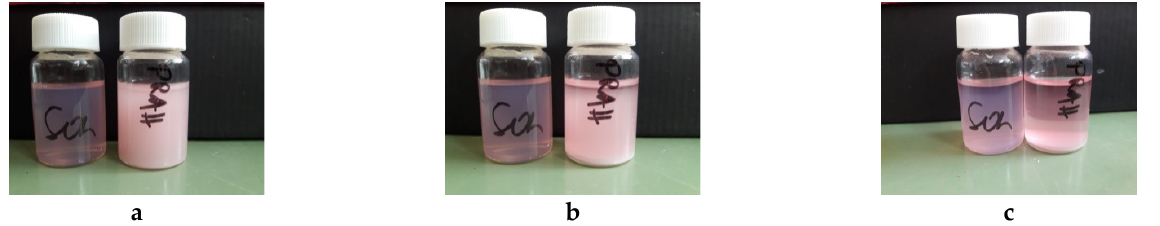
Figure 2. Visual observation of ceria sol (bottles on the left) and ceria powder-containing (bottles on the right) electrolytic baths after magnetic stirring: ( a ) 0 min, ( b ) 3 min, and( c ) 6 min.